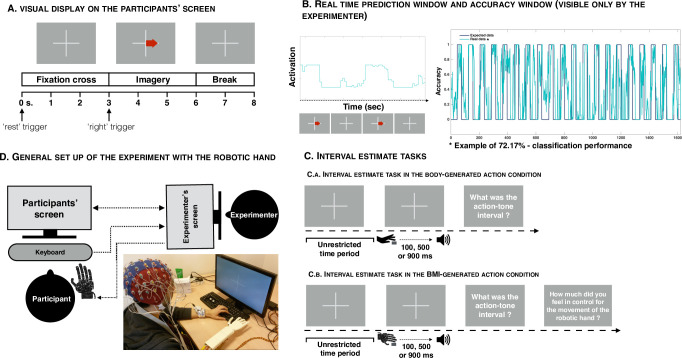
(A) Visual display of the participant’s screen during the training phase. When the cross appeared alone, the participant was told to think about nothing. When the red arrow appeared, the participant had to think about a movement of the right hand. (B) Visual display on the experimenter’s computer. On the left, the real-time prediction window and on the right, the final plot displaying the fit between the actual data and the expected data. (C) Graphical representation of the interval estimate tasks, in both the body-generated action condition (top) and the BMI-generated action condition (bottom). (D) General setup of the experiment with the robotic hand.